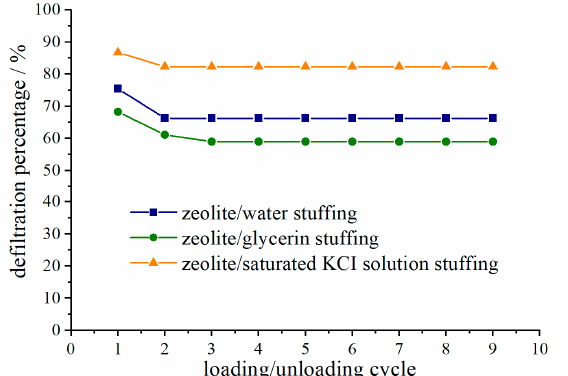
Figure 7. Defiltration percentage of three kinds of zeolite-based stuffing under ten cyclic loadings (ZSM-5 zeolite/water stuffing, ZSM-5 zeolite/glycerin stuffing, and ZSM-5 zeolite/saturated KCl solution stuffing).